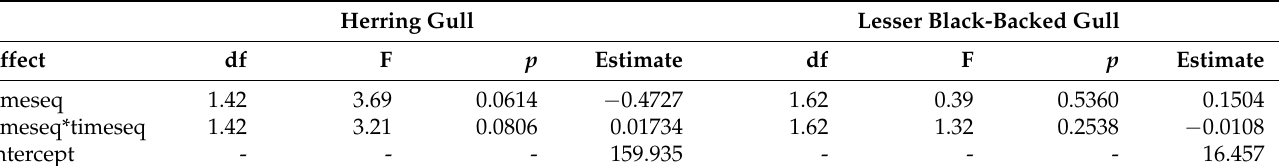
Table 4. Individuals counted (in total) and estimated number of breeding pairs (factor 0.7) using UAVs and traditional methods (ground counts of individuals) on the island of Langli during the period of study. Traditionally, the highest number of birds counted on the different ground counts is used as a survey result for the year.